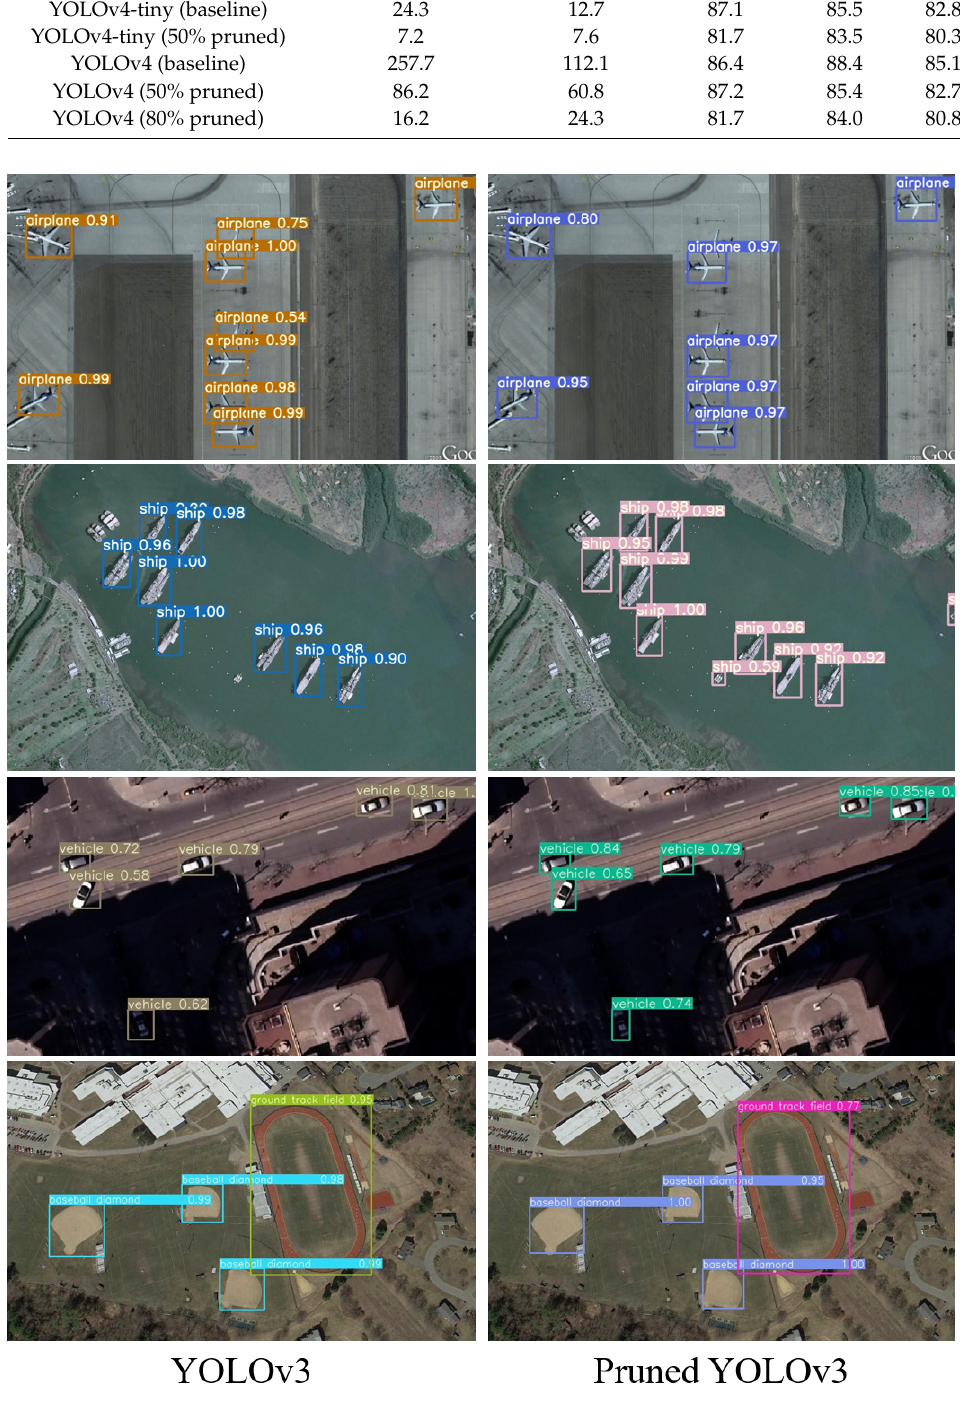
Figure 9. Visual detection results of YOLOv3 and the pruned